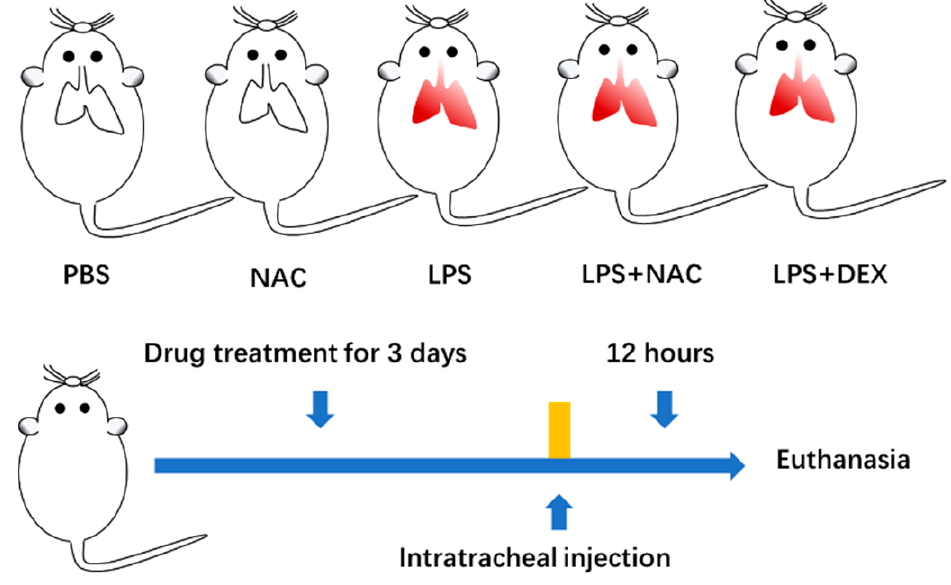
Figure 1. Mice were divided into five groups. After drug treatment for 3 consecutive days, the intratracheal injection was conducted, and they were euthanized 12 h later to collect samples.